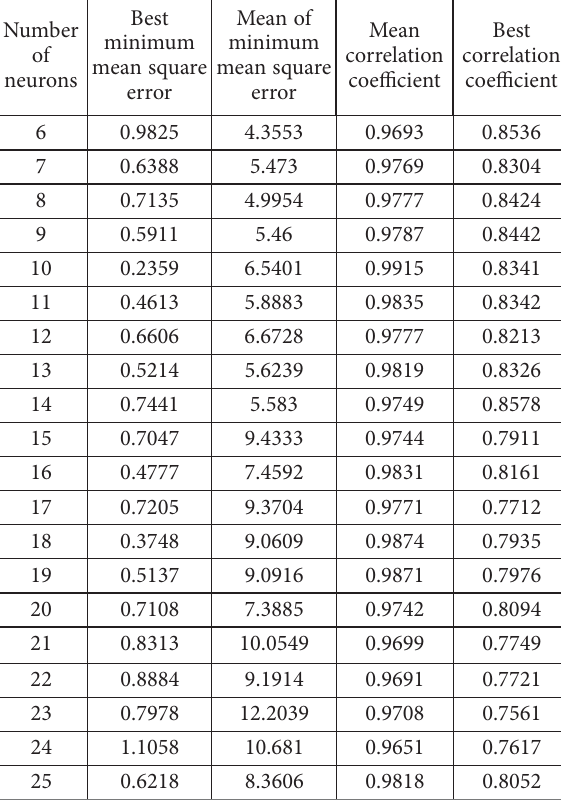
Table 4. Comparison of different ANN architecture results in 100 iterations for ( L Aeq ) in the 4 th scenario